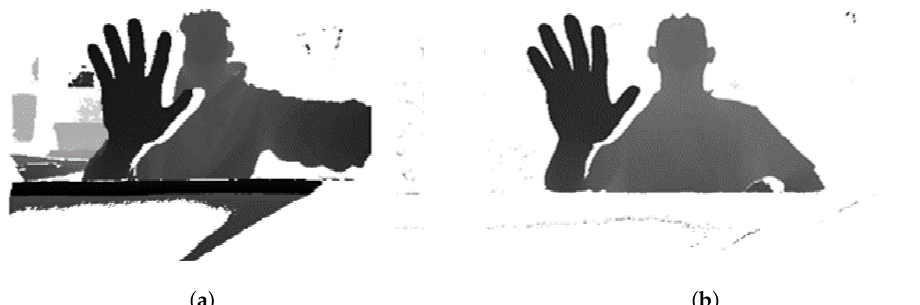
Figure 9. The experimental result before ( a ) and after ( b ) of applying the background subtraction.